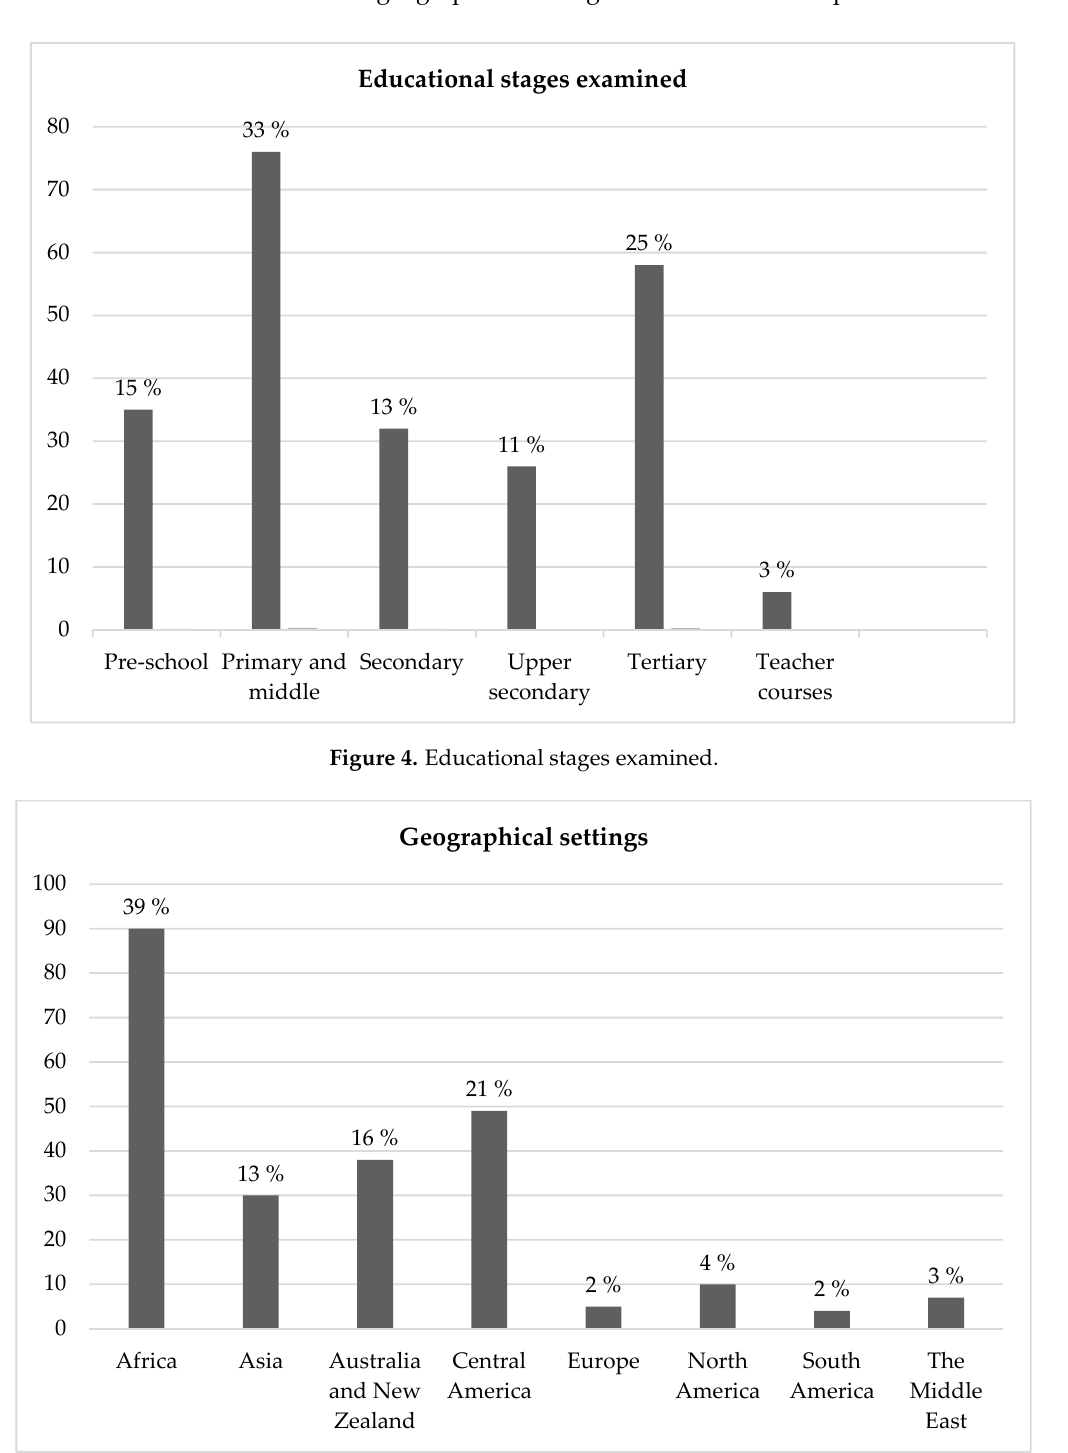
Figure 5. Geographical settings.